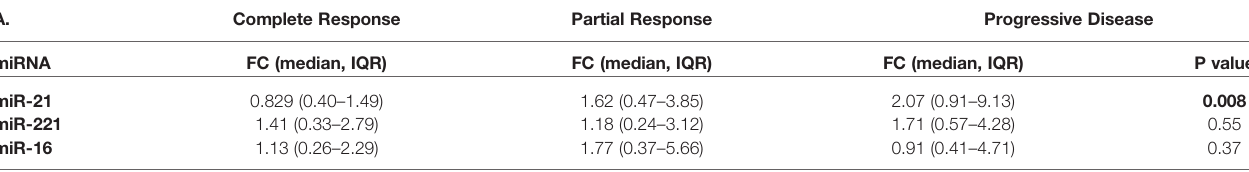
TABLE 5A | MicroRNA fold changes in different categories of response in viral-HCC patients following locoregional therapy.